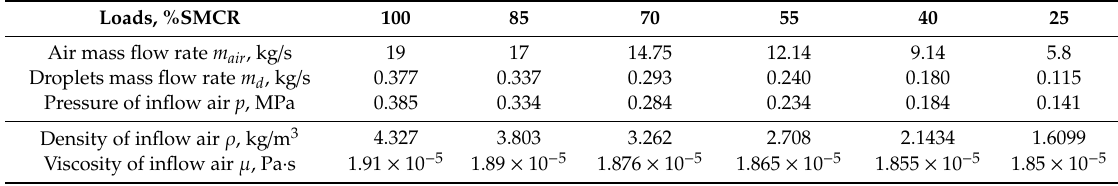
Table 2. Air inflow parameters of the separator under di ff erent